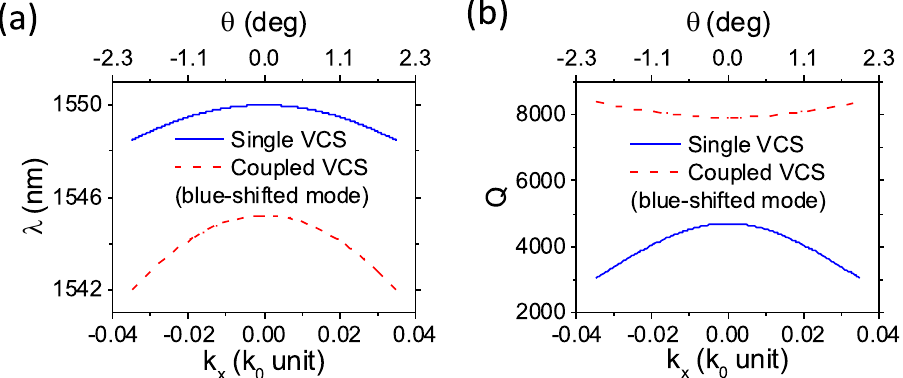
Figure 3. ( a ) The resonance wavelength λ , and ( b ) the Q-factor versus the in-plane wavevector component in the x -direction k x (or incident angle θ ), for a reference mode in single VCS (blue) and the blue-shifted mode in structure Fig. 1 (red). The dispersion curvature is 125 and 270 m 2 /s for the single and coupled VCS case, respectively. The Q-factor of the coupled cavity mode has larger values, which remains large for small k x values, while that of the single cavity mode drops rapidly. Simulation details are provided in Supplementary